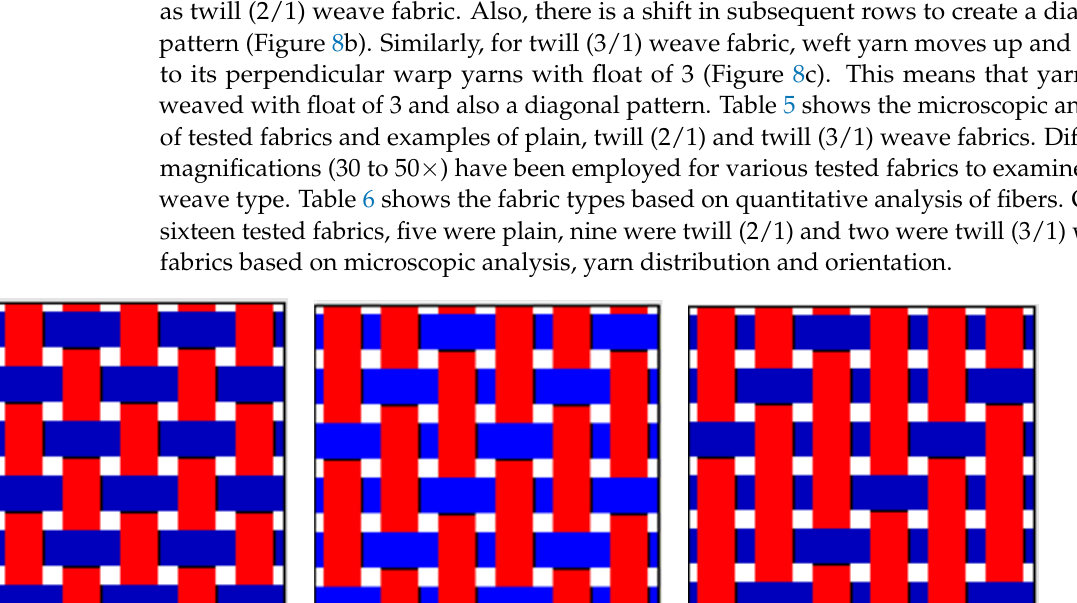
Figure 7. Testing setup for tensile testing of TRM specimens ( a ) TRM specimen with prepared ends ( b ) TRM specimen gripped in machine.